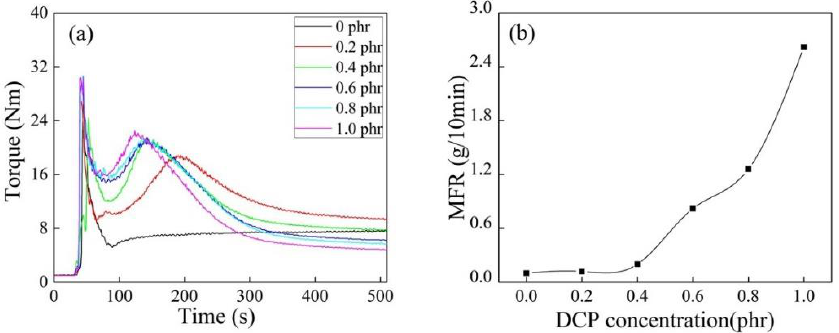
Figure 5. Torque/time spectra ( a ) and MFR ( b ) of iPB-g-MAH at different DCP concentrations.